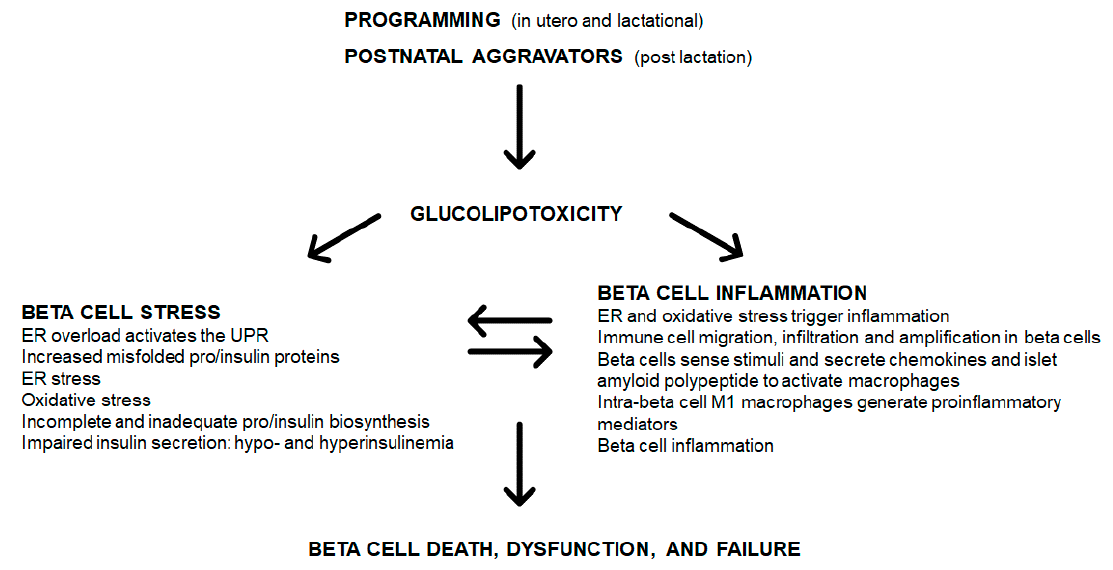
Figure 1. Programming, glucolipotoxicity, beta cell stress, and inflammation: convergence on beta cell death, dysfunction, and failure.